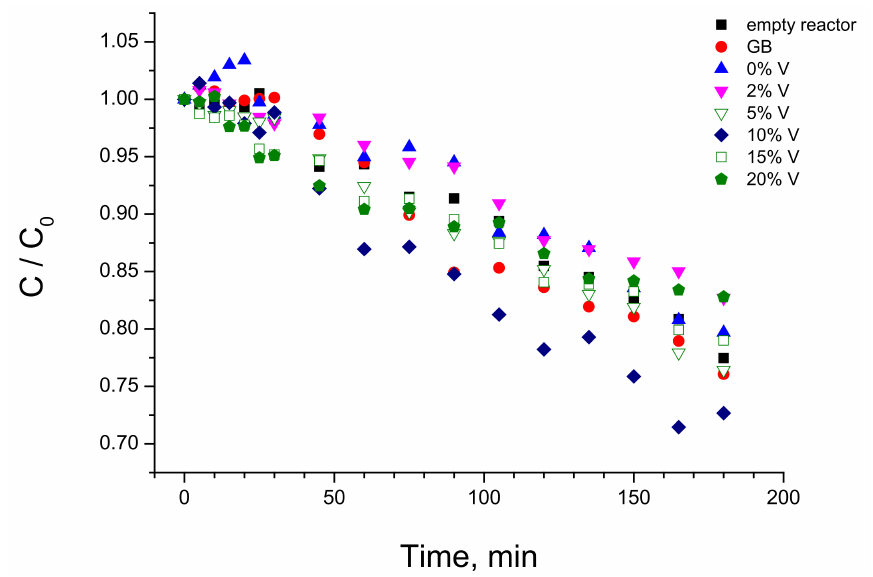
Figure 10. Kinetics of MB decomposition with VIS lamp illumination ( λ > 385 nm) using V-TiO 2 coated glass beads with different vanadium content (in